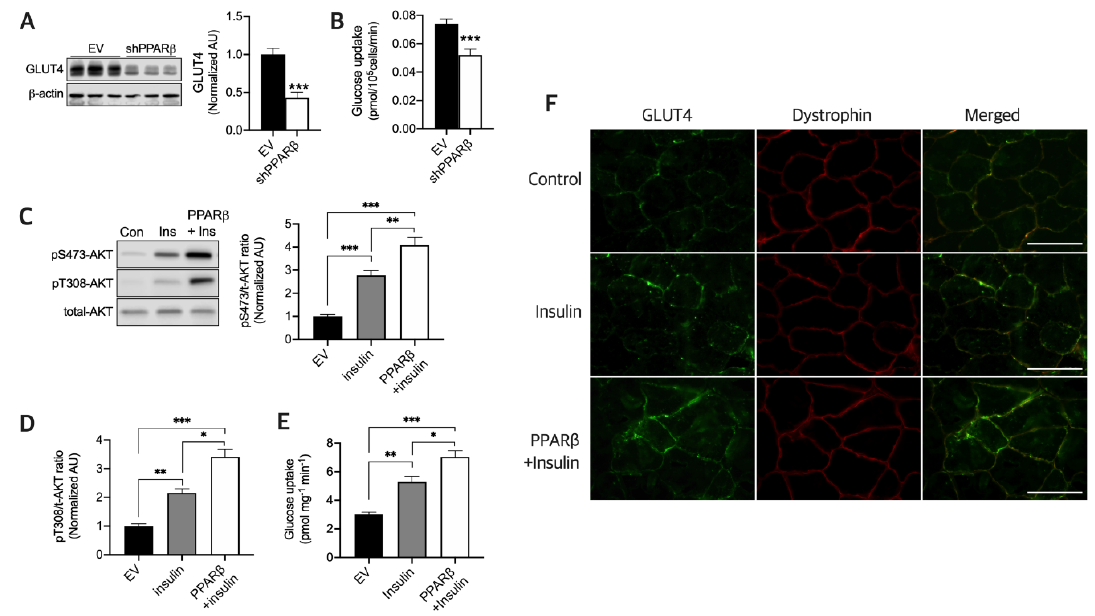
Figure 2. PPAR β is required to maintain normal glucose uptake and maximize insulin sensitivity. ( A ) Silencing of PPAR β (shPPAR β ) downregulated GLUT4 ( n = 6 myotubes per group). ( B ) Silencing of PPAR β (shPPAR β ) decreased glucose uptake ( n = 9 myotubes per group). ( C–E ) PPAR β synergistically increases insulin-induced AKT activation and glucose uptake ( n = 6 myotubes per group). Values are means ± SE. * p < 0.05, ** p < 0.01, *** p < 0.001. ( F ) PPAR β enhances insulin-induced GLUT4 localization to the plasma membrane. Scale bar, 100 µ m. Significance was determined using one-way ANOVA or Student’s t -test.